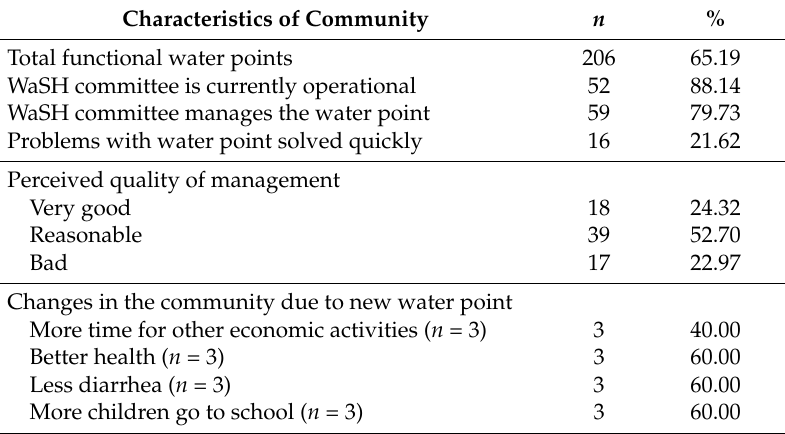
Table 3. Functionality and management of water points in intervention and control communities.